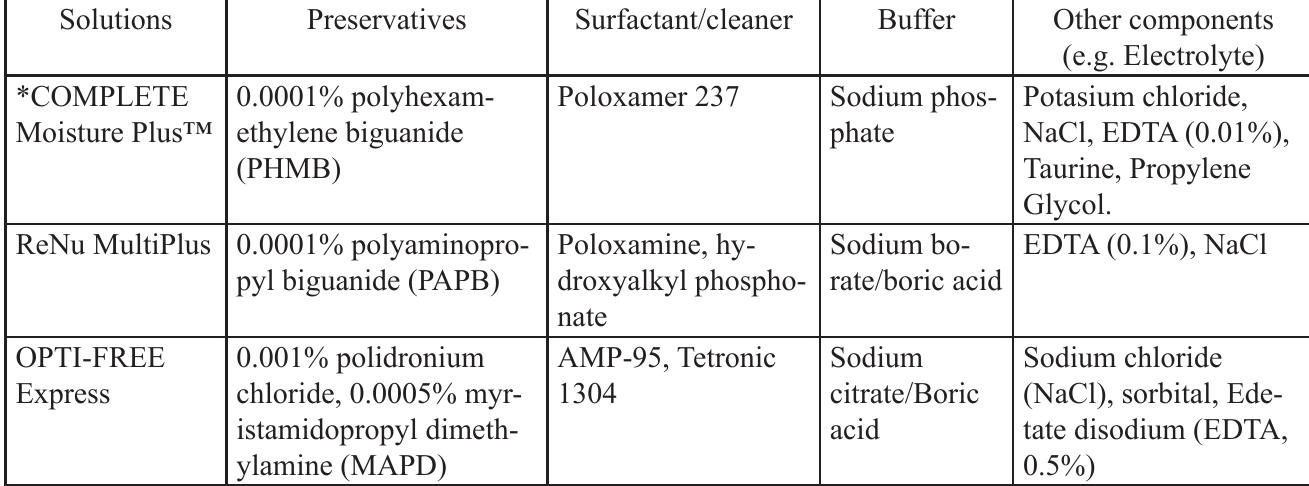
Table 1. Composition of the various multipurpose